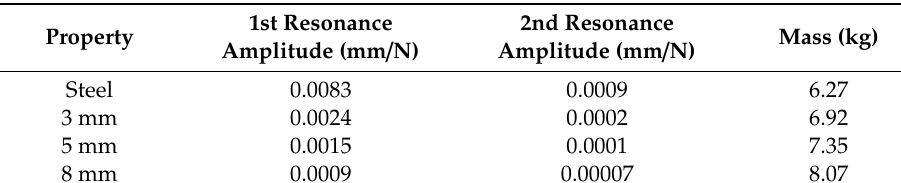
Table 4. Free-free beams receptance function amplitudes for the first two resonances.